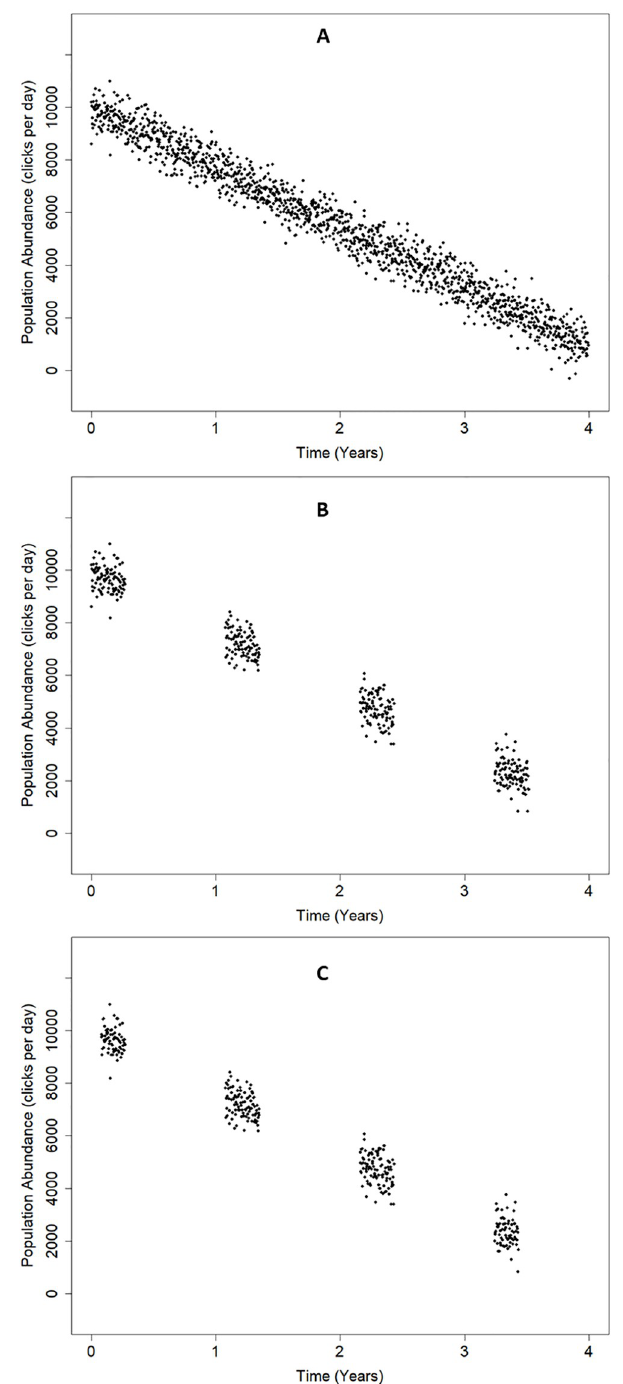
Fig 2. Scenario 2: Uniform downward population trend. (A) complete data , (B) incomplete data and (C) paired data .